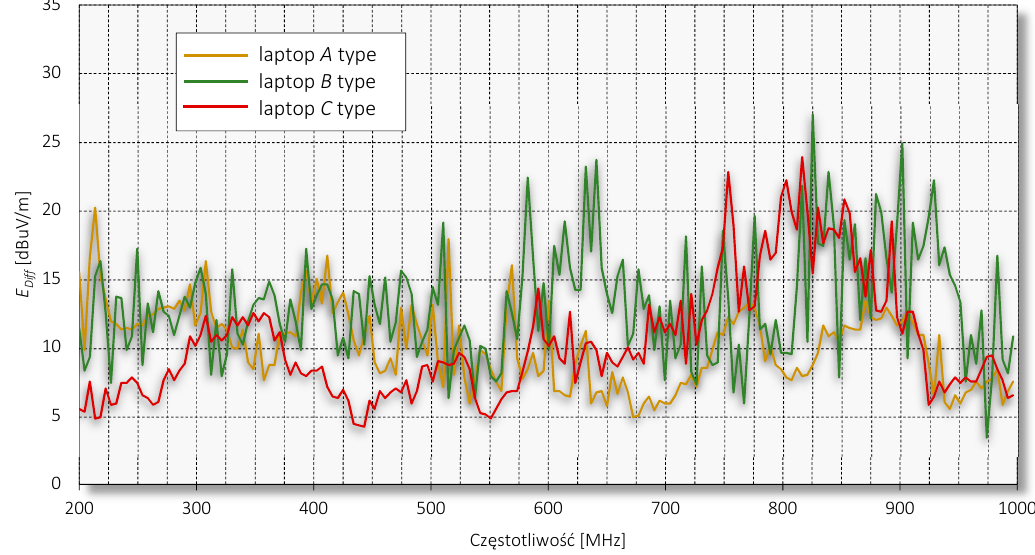
Figure 10. Differences of measured levels of electromagnetic (EM) disturbances (valuable emissions) for three types of laptops in the range of frequencies from 200 MHz to 1 GHz.